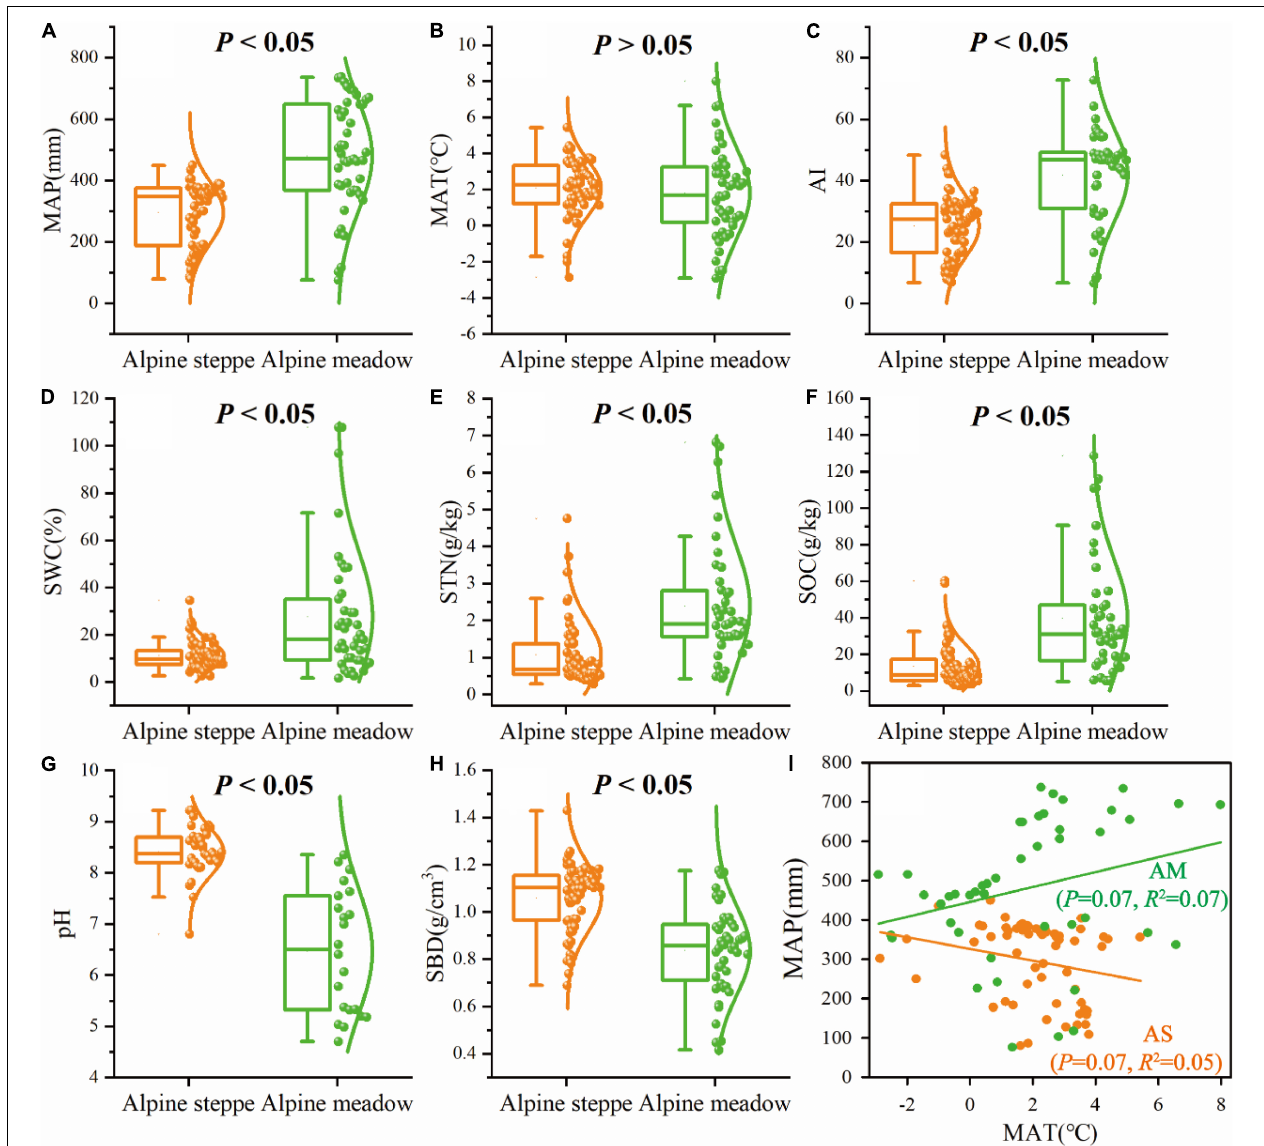
FIGURE 4 | Box-and-whisker plots showing changes in the (A) mean annual precipitation (MAP), (B) mean annual temperature (MAT), (C) aridity index (AI), (D) soil water content (SWC), (E) soil total nitrogen (STN), (F) soil organic carbon (SOC), (G) soil pH (pH), and (H) soil bulk density (SBD) in alpine steppe (AS) and alpine meadow (AM), P -values indicate level of significant differences between alpine steppe and alpine meadow. (I) The relationships between MAP and MAT across alpine steppe (AS) and alpine meadow (AM).